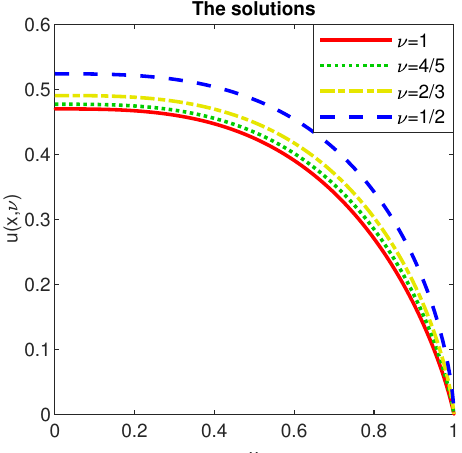
Figure 4. Chebfun solutions to problem (13) for various values of ν